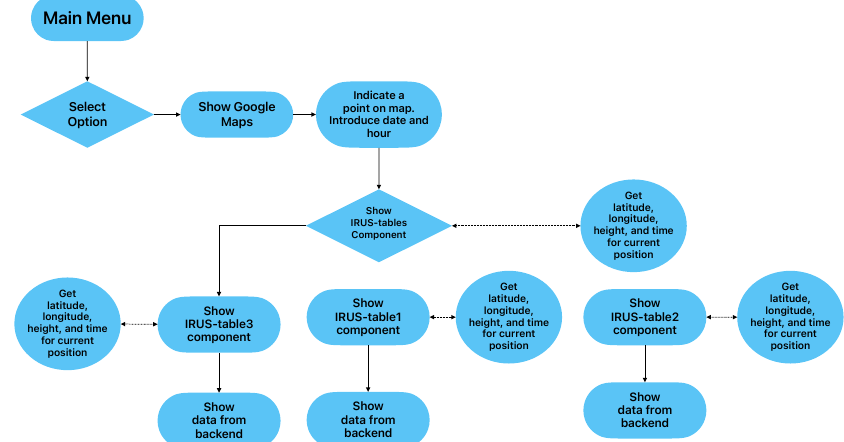
Figure 4. Workflow of the application for generation of routes and